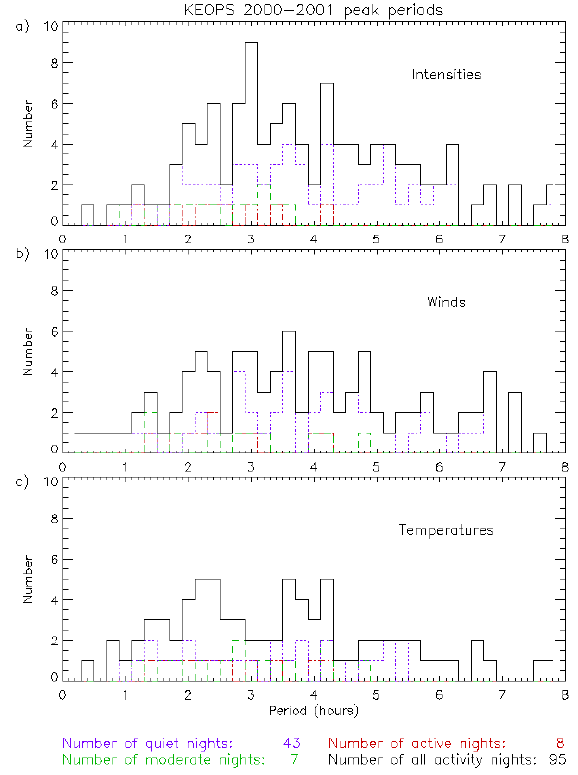
Fig. 15. Monthly counts of gravity waves per number of clear nights, from KEOPS during 2000–2001: (a) intensities, (b) winds, and (c)